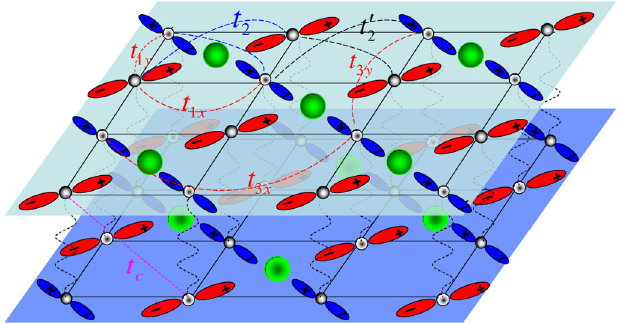
FIG. 3. A sketch of the d and d orbitals, their orientations, x 0 z y 0 z and their coupling into the two As(Se) layers. The hopping parameters are indicated: The nearest-neighbor hopping is and t 1 ; the next-nearest-neighbor hoppings are marked by t 1 x y t 2 and t 0 2 due to the broken symmetry along two different diagonal directions; and the third NN hopping is marked by t 3 and t 3 . The coupling between the two layers is marked x y by the nearest-neighbor hopping t c